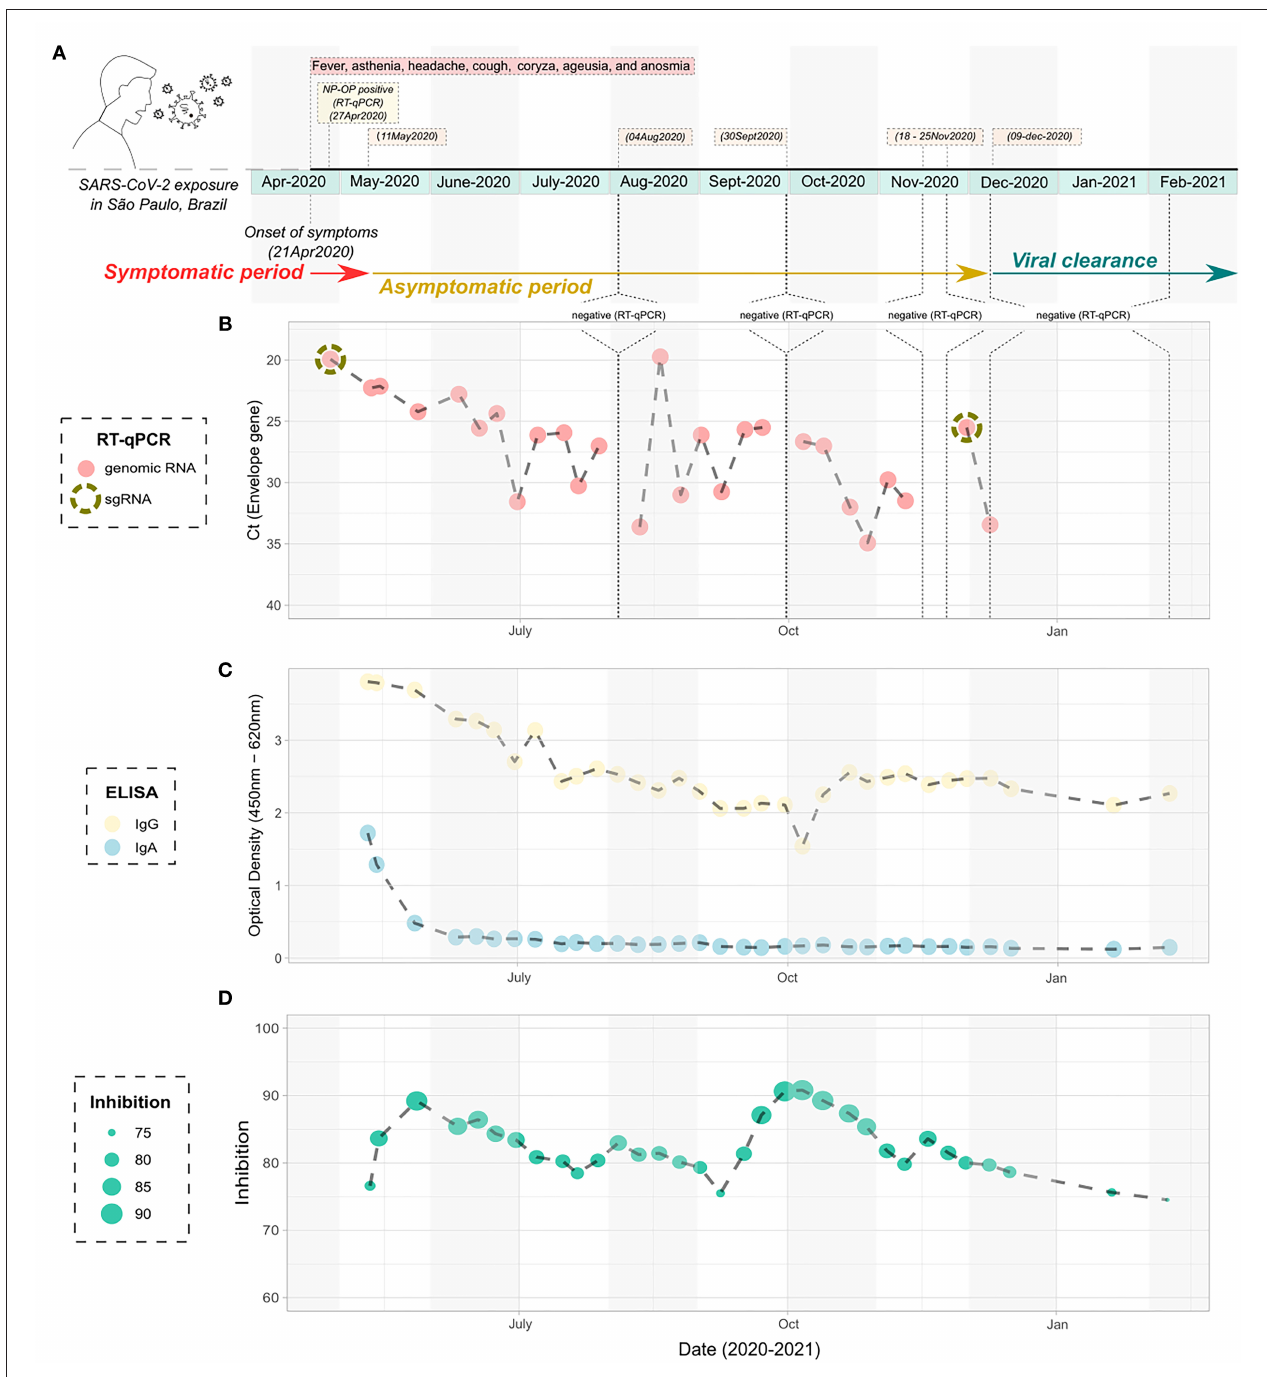
FIGURE 3 | Timeline infection of the atypical studied patient with prolonged detection of viral RNA. (A) Schematic figure containing the diagnostic points, harvesting, and symptoms over time. (B) Cycle threshold to the Envelope gene of the SARS-CoV-2 according to the timeline of infection, as determined by RT-qPCR. The NP-OP swabs positive to the detection of subgenomic RNA are indicated by the dashed circle. (C) ELISA data showing the detection of IgA and IgG specific anti- SARS-CoV-2 nucleocapsid according to the timeline of infection. (D) Inhibition of the SARS-CoV-2/ACE2 ligation mediated by receptor-binding domain by neutralizing antibodies, according to the timeline of infection. SARS-CoV-2, severe acute respiratory syndrome coronavirus 2; NP-OP, nasopharyngeal-oropharyngeal; ELISA, enzyme-linked immunosorbent assay.